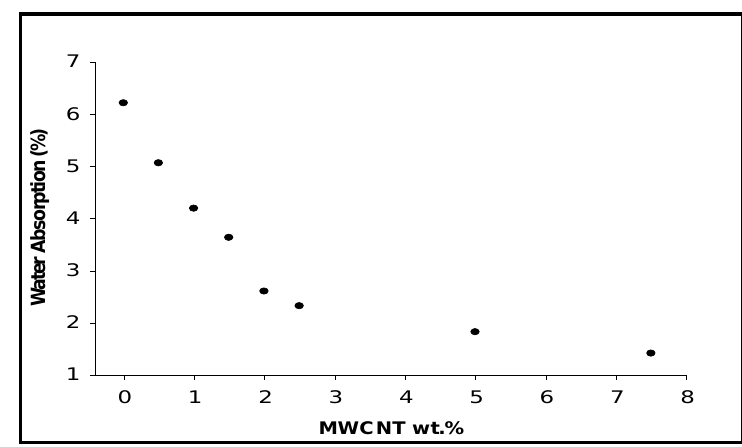
Figure 13. Water absorption (%) in the Ar-CNT-P composite films vs CNT loading.